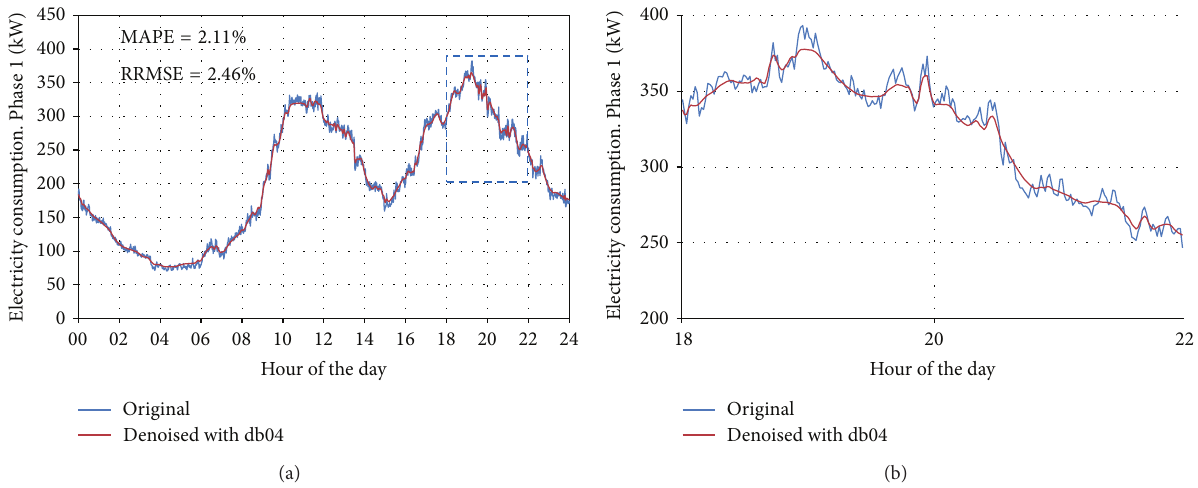
Figure 10: (a) Original and denoised (db04 wavelet) load curves fragment for a Thursday in winter (10/02/2005). (b) Load curves fragment from 18 to 22 hours.